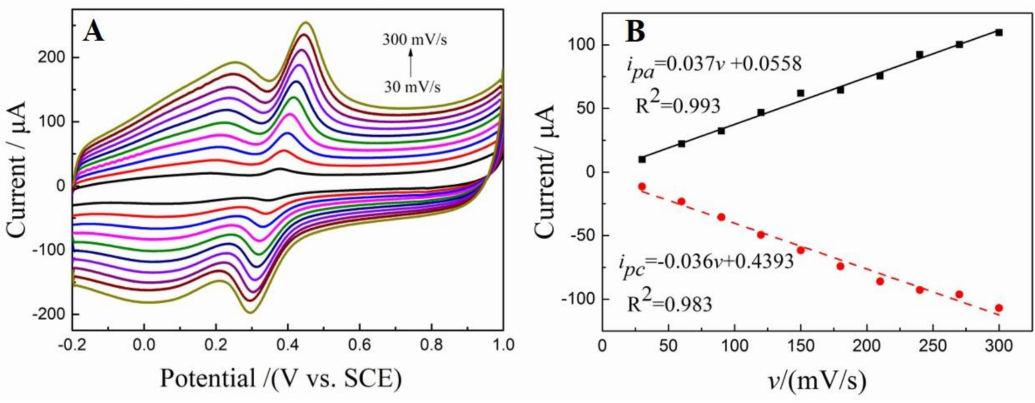
Figure 5. ( A ) The cyclic voltammograms of dopamine on the MnO 2 NWs-RGO/GCE at different scanning rates; ( B ) Relationship between oxidation peak current ( i pa ) and scanning rate ( v